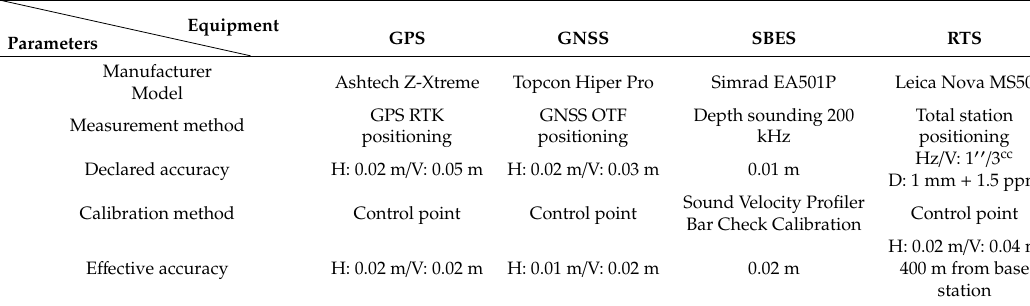
Figure 4. Bathymetric monitoring ( a ) measurements condition, ( b ) stages of measurements, ( a1 ) study area measurements condition, ( a2 ) bathymetric equipment, ( a3 ) rough bottom and turbulent water flow, ( b1 – b4 ) hydrographic motorboat trajectories during measurement stages. Table 1. Equipment used during bathymetric